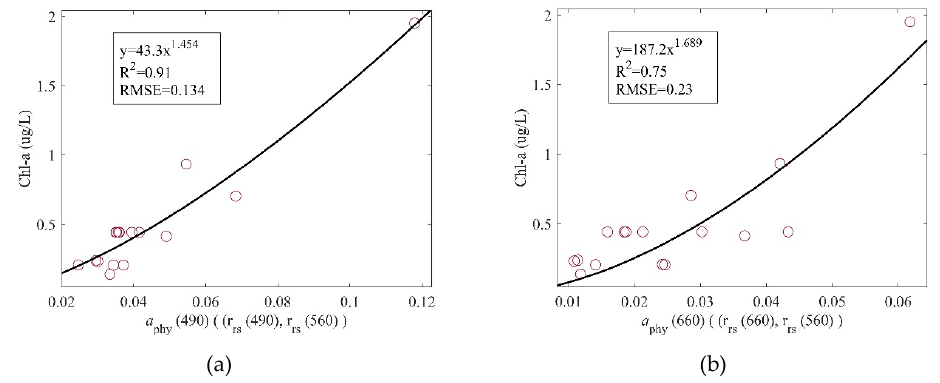
Figure 11. Scatterplots of the Chl-a concentration as a function of ( a ) a phy (490) calculated by r rs (490) and r rs (560), and ( b ) a phy (660) calculated by r rs (560) and r rs (660). RMSE, root mean square error.